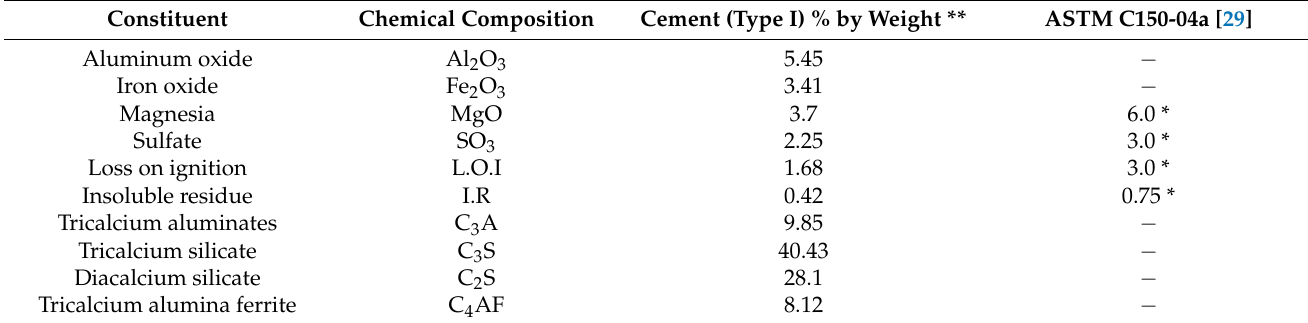
Table 1. Portland cement composition.